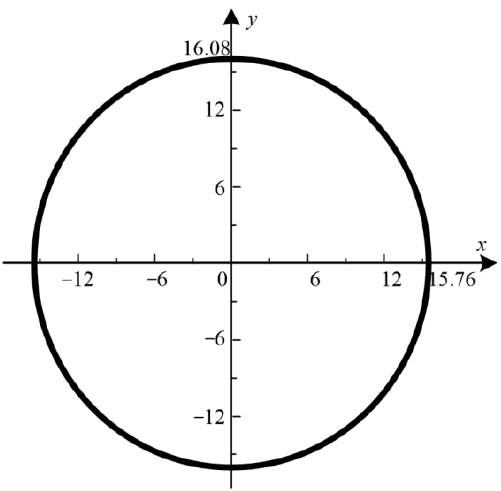
Figure 6. Profile curve of the elliptical cam wave generator. For the disposable harmonic drive, φ r and φ g can be expressed as: